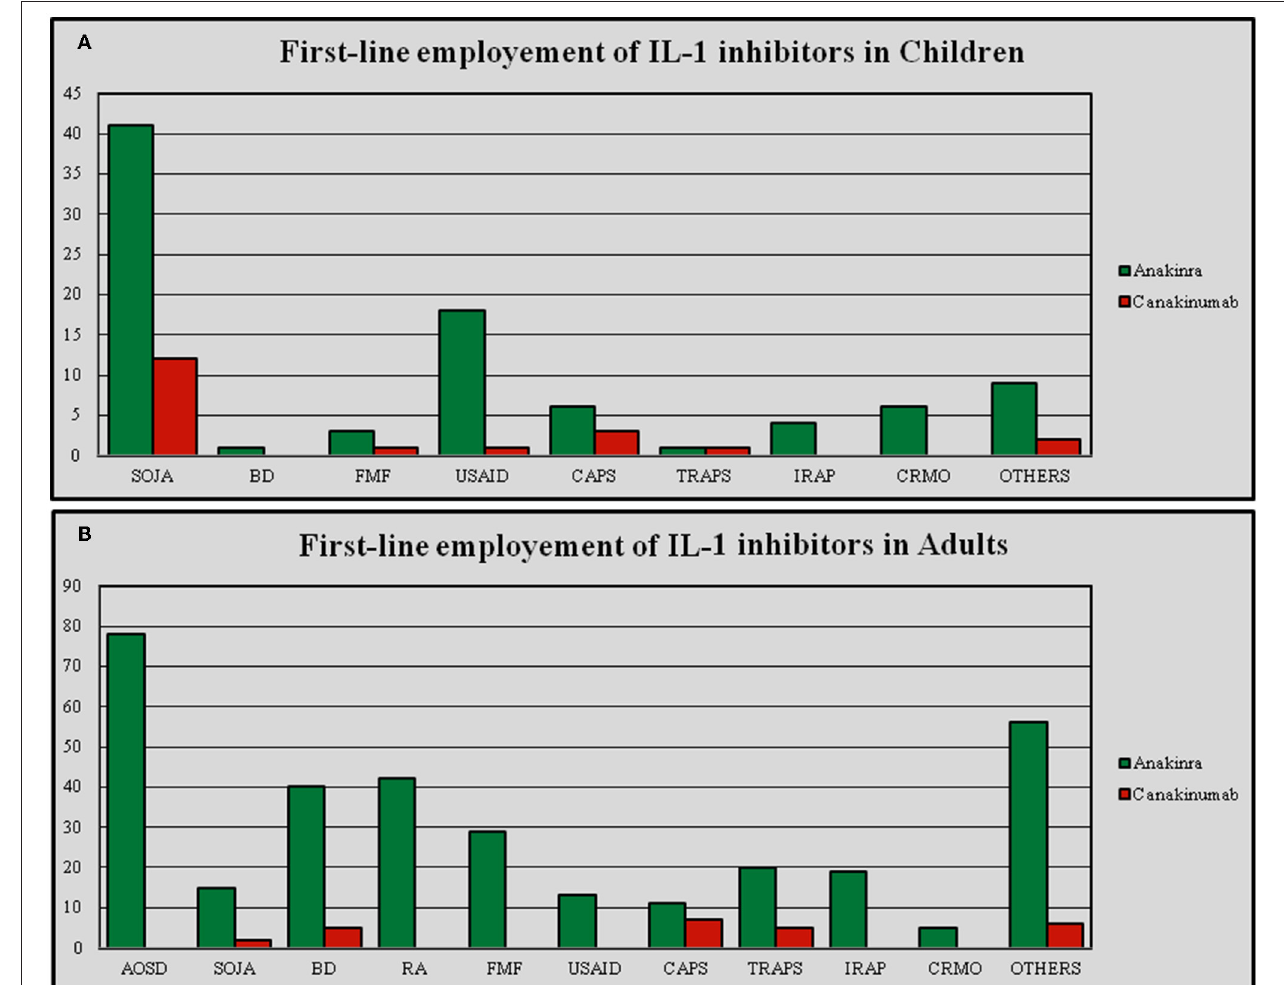
FIGURE 5 | First-line employment of Anakinra and Canakinumab in different indications differentiating between pediatric (A) and adult patients (B). AOSD, Adult Onset Still’s Disease; BD, Behçet’s Disease; CAPS, Cryopyrin-Associated Periodic Syndrome; CRMO, Chronic Recurrent Multifocal Osteomyelitis; FMF, Familial Mediterranean Fever; IRAP, Idiopathic Recurrent Acute Pericarditis; RA, Rheumatoid Arthritis; SOJA, Systemic Onset Juvenile Idiopathic Arthritis; TRAPS, Tumor Necrosis Factor Receptor-Associated Periodic Syndrome; USAID, Undifferentiated Systemic AutoInflammatory Disease.